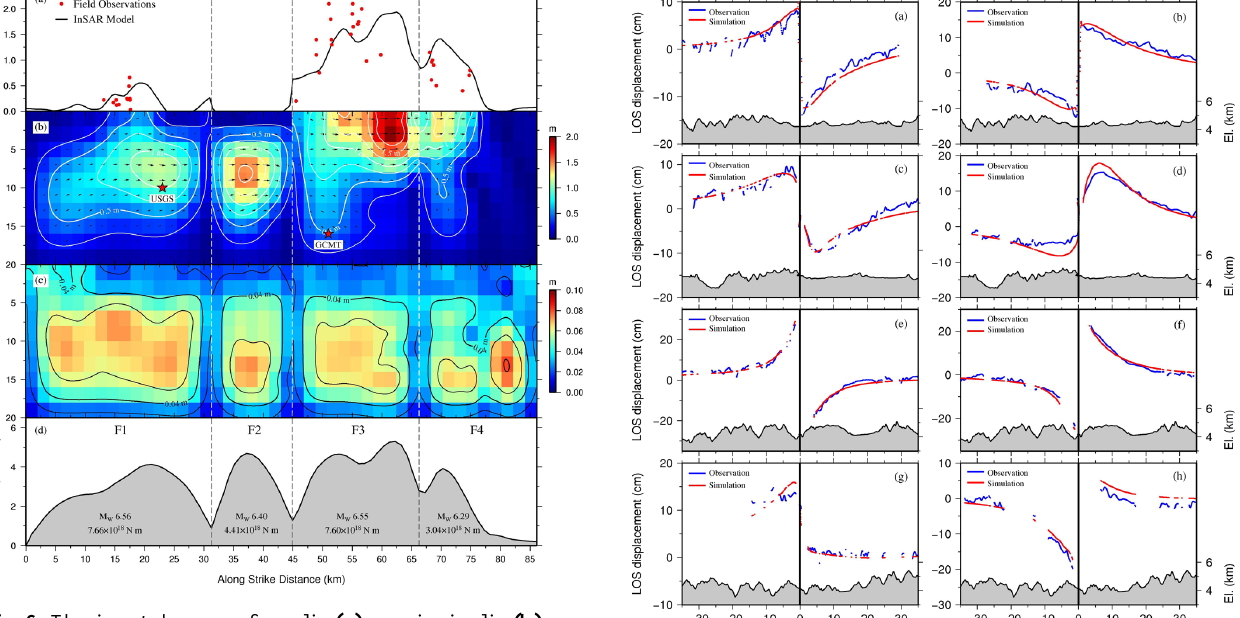
Fig. 6. The inverted near-surface slip (a) , coseismic slip (b) , co- seismic slip errors (c) and depth integrated moment along strike of the fault (d) from InSAR observations. The inverted near- surface slip is taken from the top two kilometers cell of the model. The red stars are the epicenter from USGS (http://earthquake. usgs.gov/earthquakes/eqinthenews/2010/us2010vacp) and GCMT (http://www.globalcmt.org).